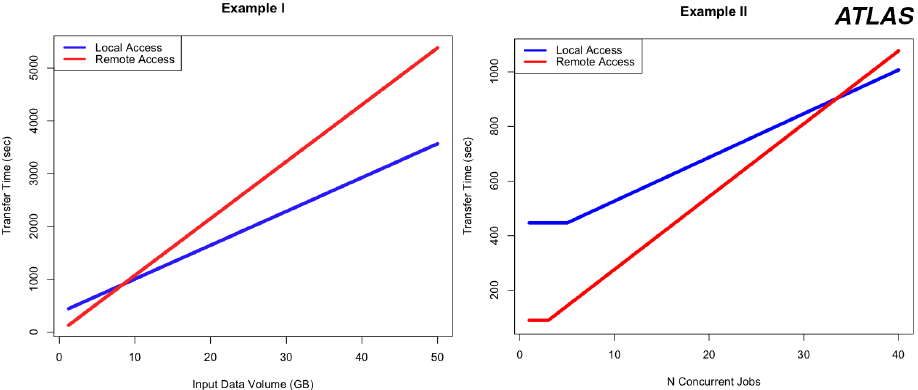
Figure 1. Example grid topology.